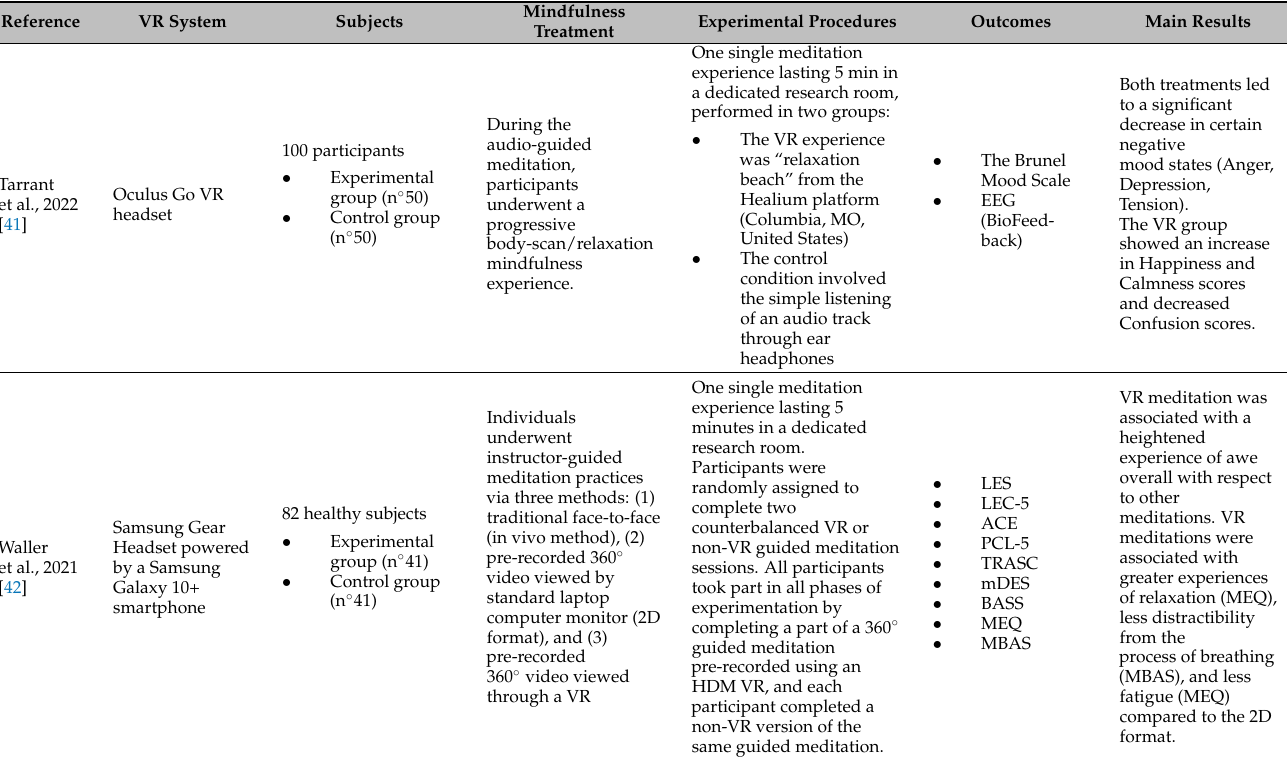
Table 1. Characteristics of studies applying mindfulness-based interventions with virtual reality